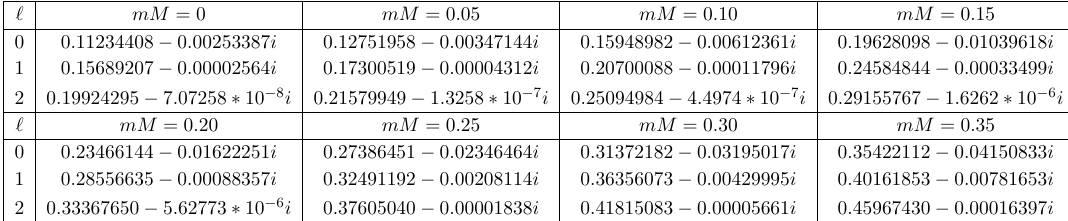
Table 9 . Fundamental quasinormal frequencies !M ( n = 0) of massive scalar (cid:12)elds with ‘ = 0 ; 1 ; 2 in the background of Schwarzschild-AdS black holes with M 2 (cid:3) = (cid:0) 0 :